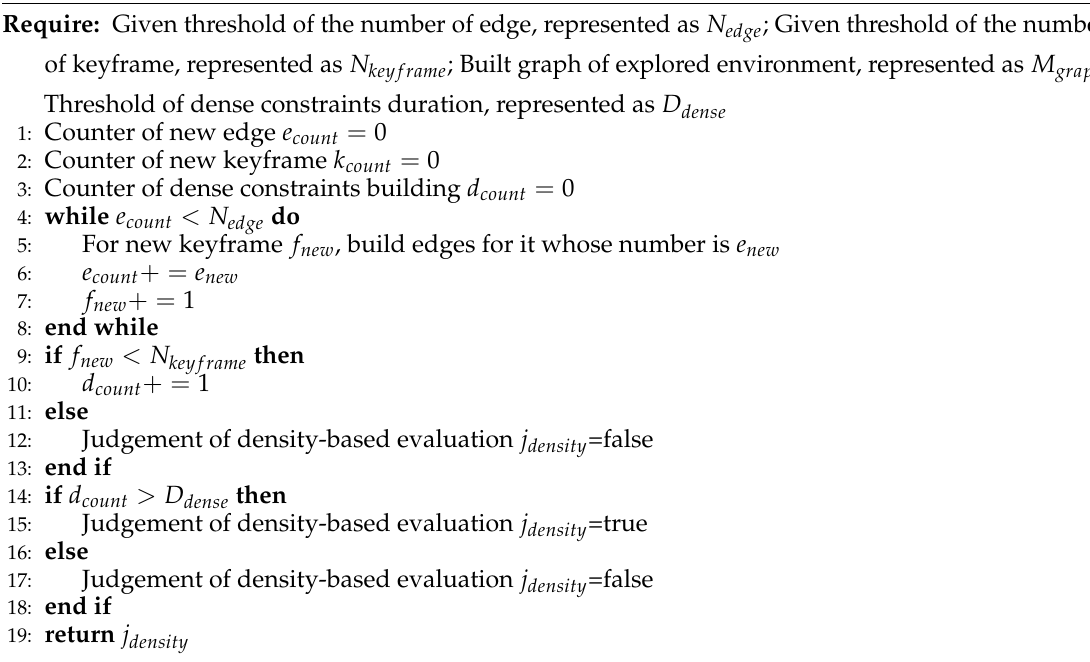
Algorithm 3 Density-based completeness